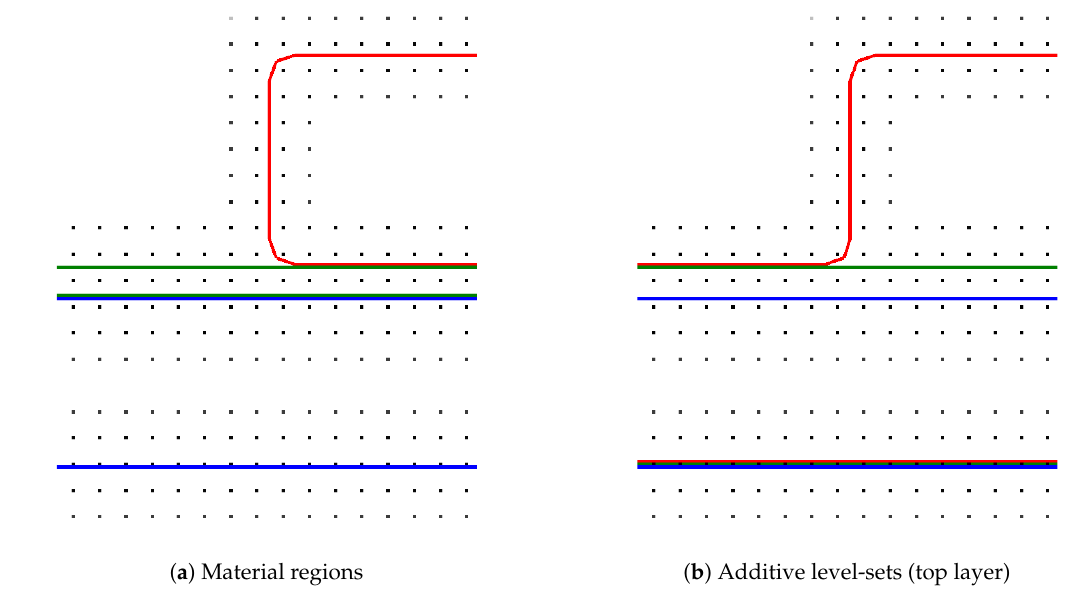
Figure 3. Three materials stack with a thick bottom region (blue), a thin layer (green), and a mask (red). ( a ) cross section of the material regions showing the level-set grid points and the extracted level-sets; ( b ) additive level-sets scheme from bottom to top (blue, green, and